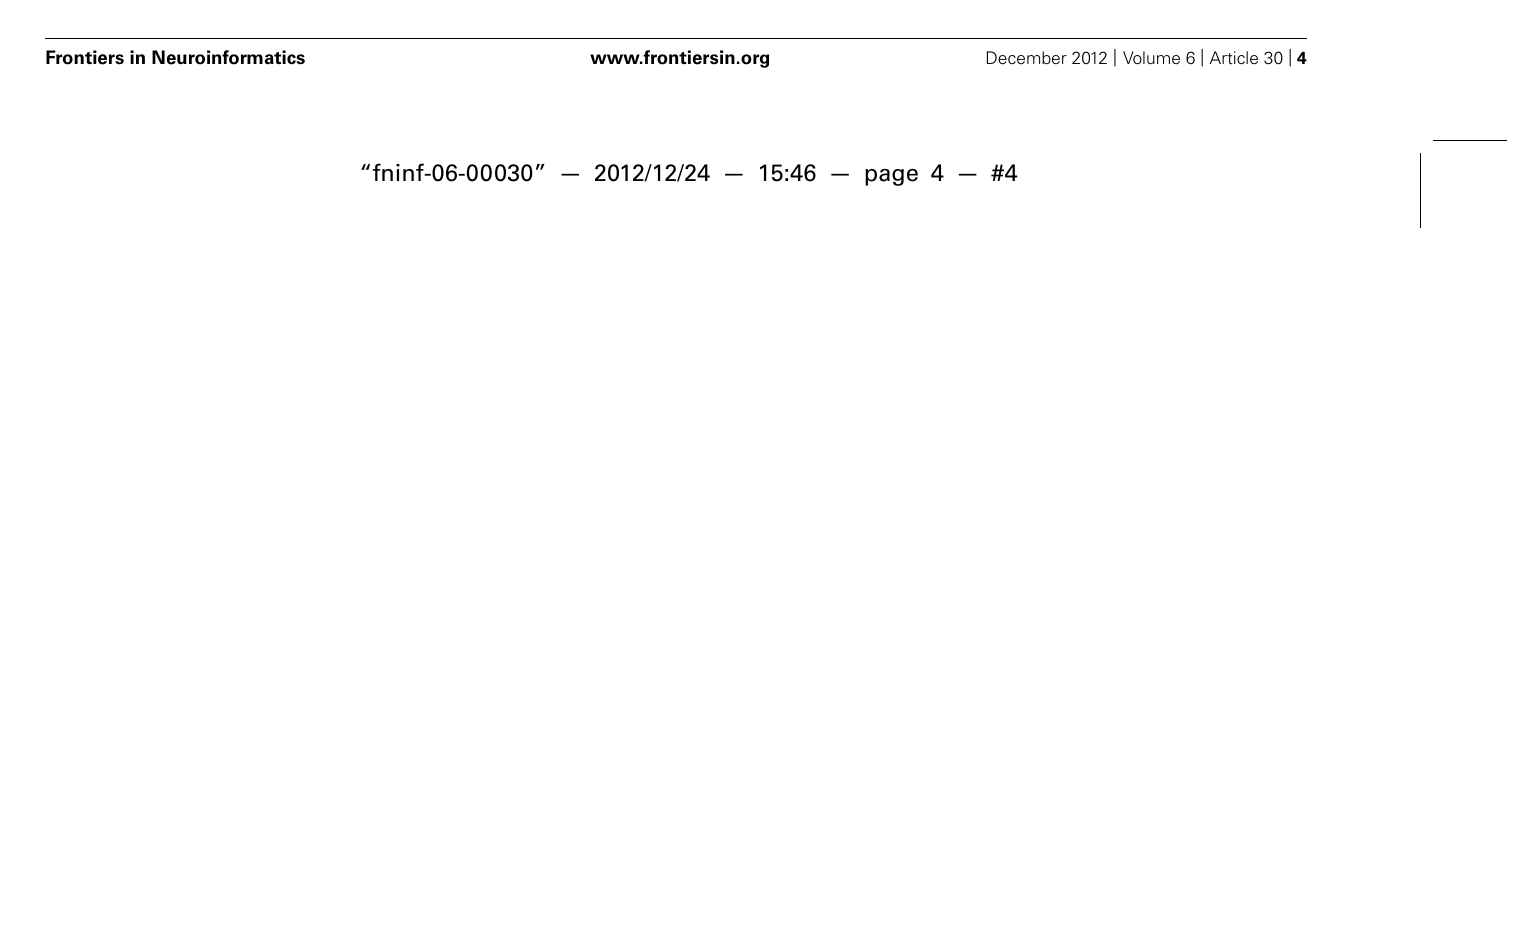
FIGURE 2 | Connectivity display using the Scalable BrainAtlas display engine (scalablebrainatlas.incf.org/cocomac), here displaying axonal projections that originate in parietal area